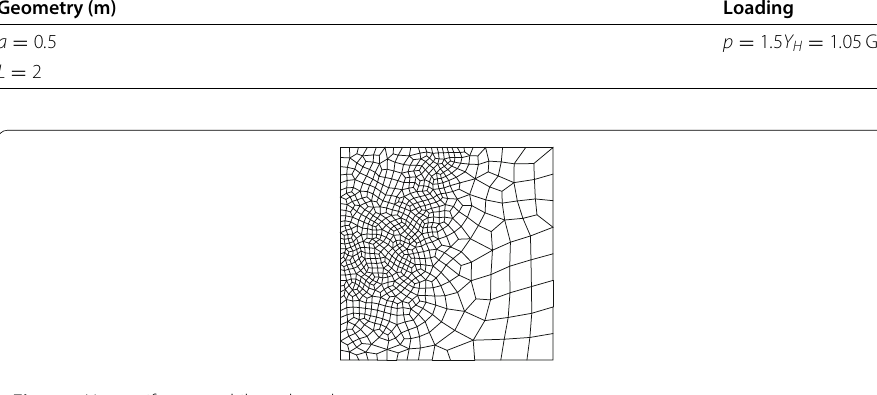
Table 2 Parameters of the partial impact test case Geometry (m)